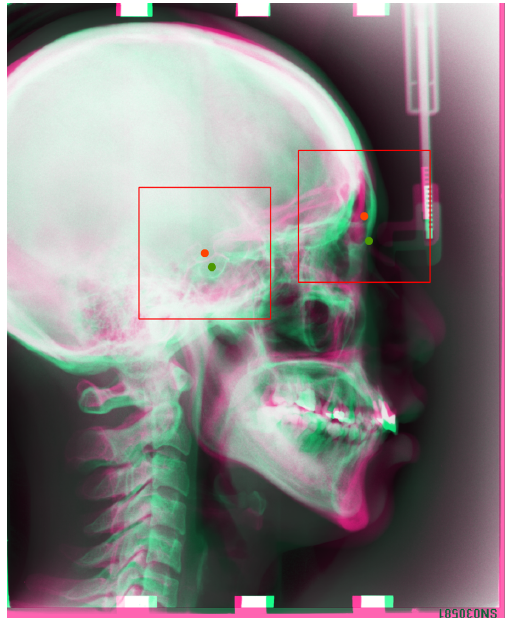
Figure 5. In the image, we take the reference image’s landmarks(Training images) as center of the patch image, then we draw a bounding box (ROI) in the test image, as the input to our corresponding trained models. Red dots are the reference images’ landmarks, green dots are test image’s landmarks, which are the landmarks we aim to detect.